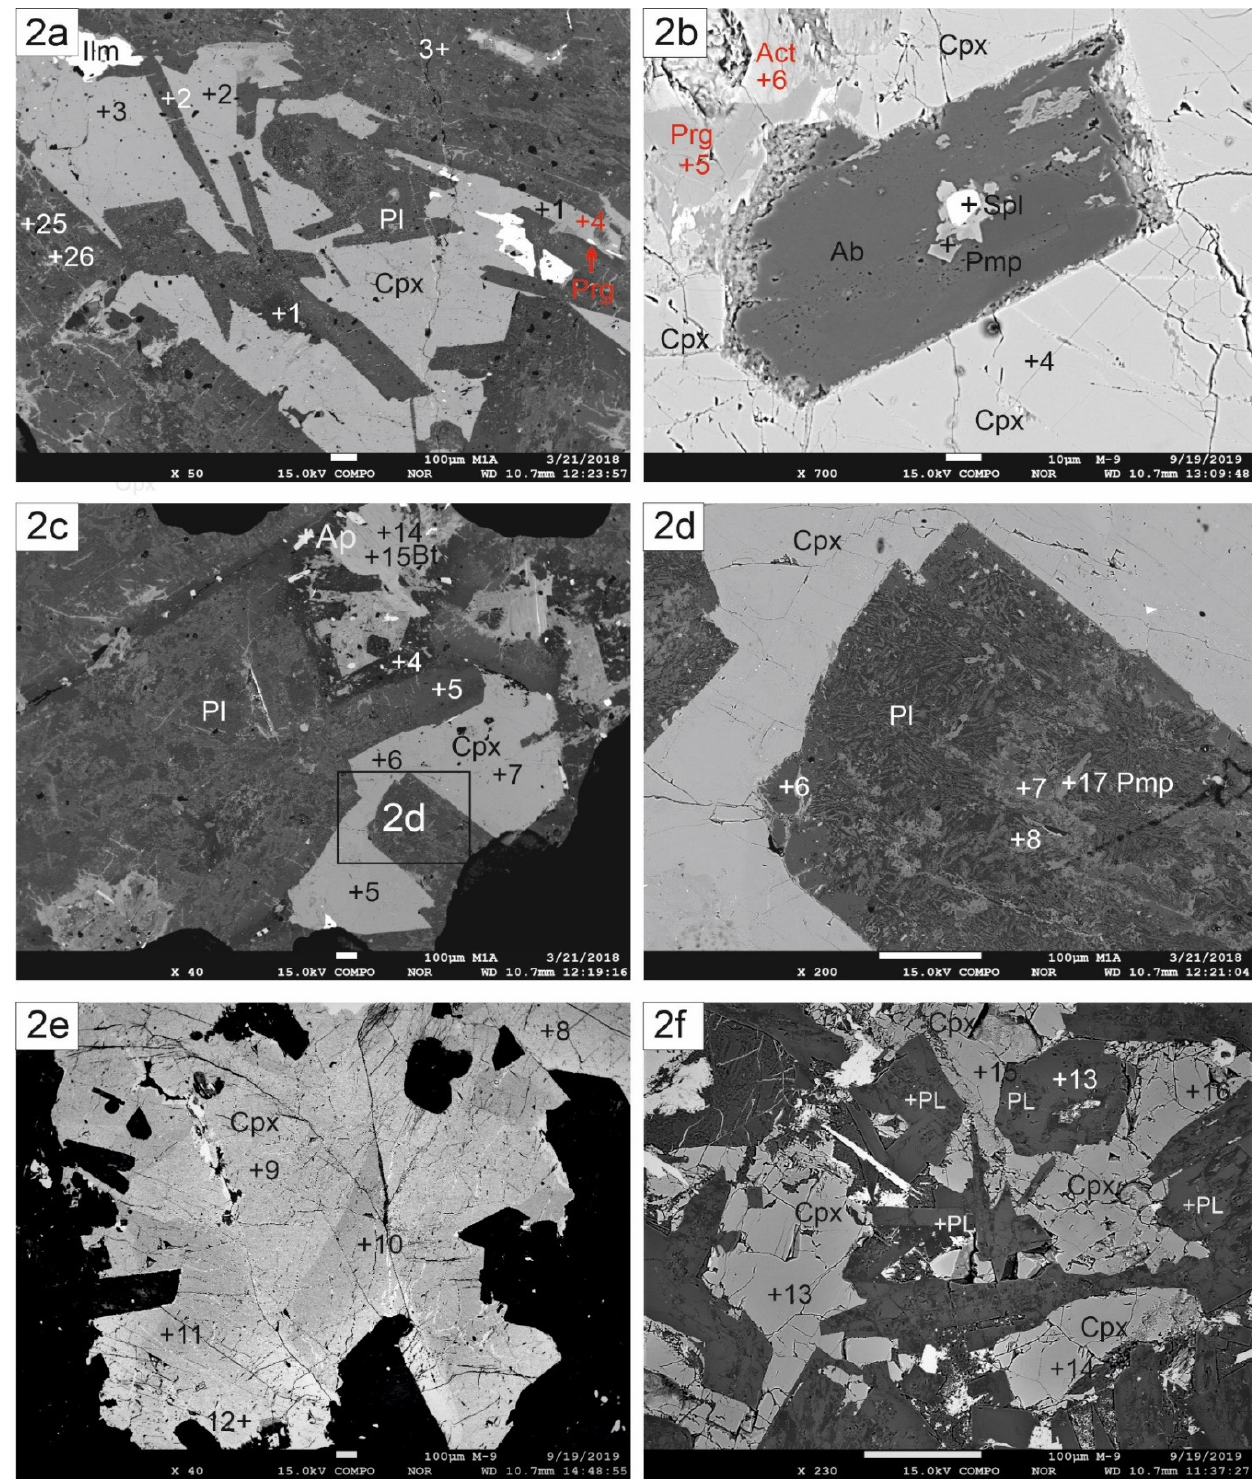
Figure 2. Back scattered electron (BSE) images of basalts from Malužiná; ( a )—overgrowth Pl and Cpx, ( b )—porphyric Pl around Cpx; ( c )—altered Pl, ( d )—detail of alterered Pl with Pmp, ( e )—zonal porphyric Cpx, ( f )—texture of basalt with Pl and Cpx; Cpx = clinopyroxene, Prg = pargasite, Act = actinolite, Pl = plagioclase, Bt = biotite, Pmp = pumpellyite, Ilm = ilmenite; the numbers in figures correspond to those in Tables 2–5.